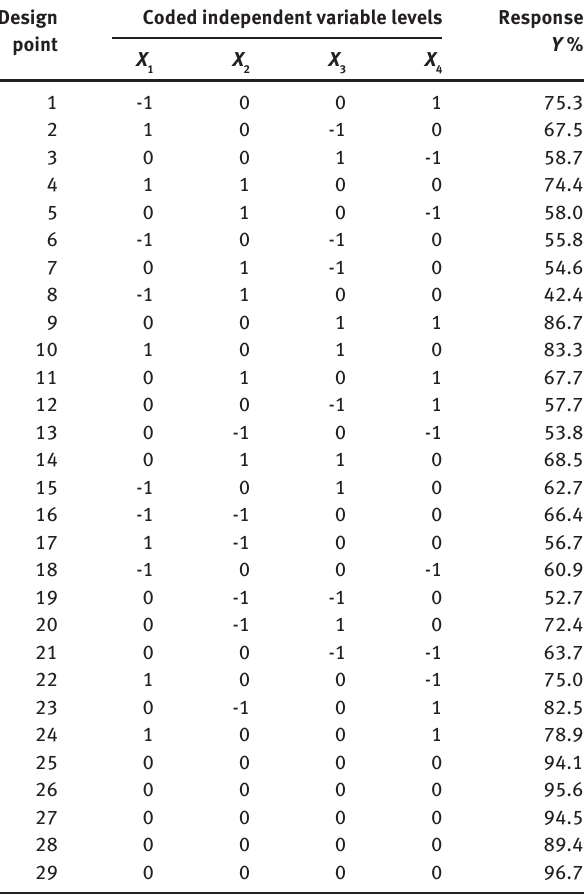
Table 2 Response surface methodology (RSM) design and